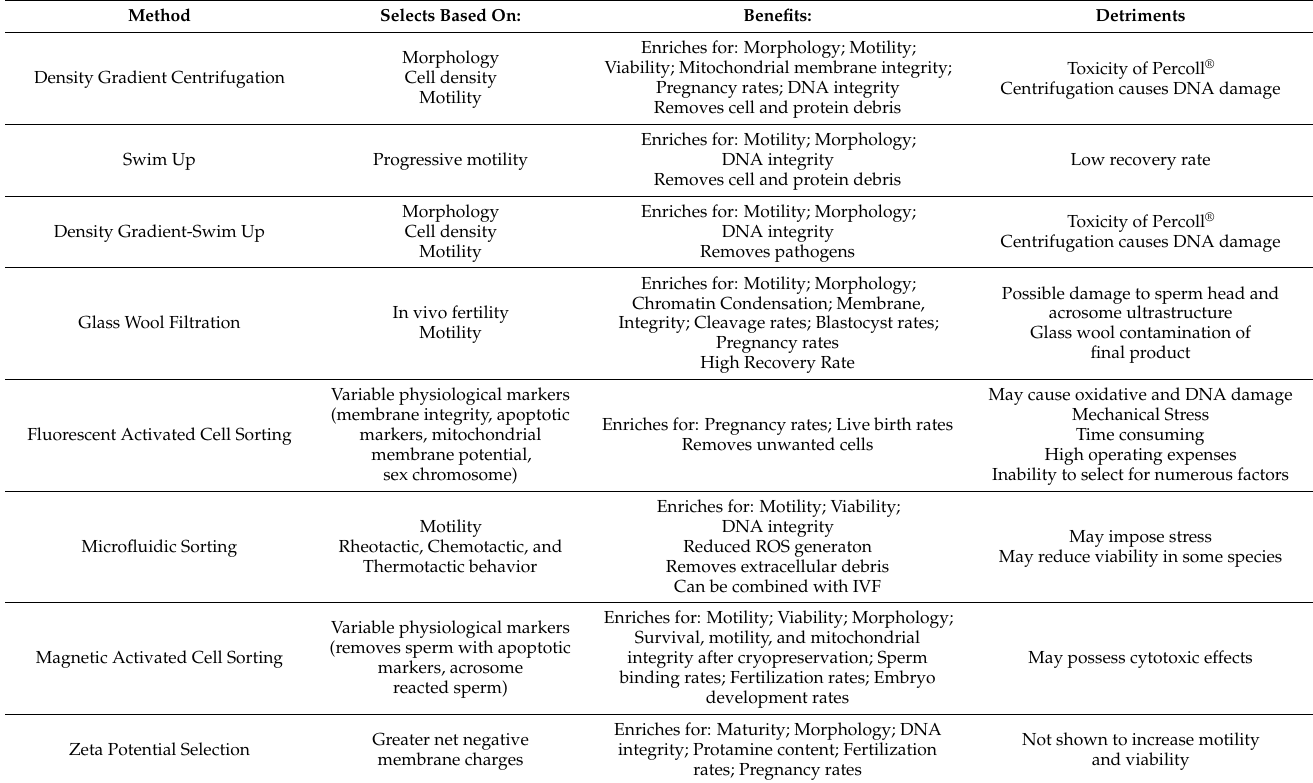
Table 1. Sperm selection techniques select for a variety of sperm parameters and are capable of reducing percentages of negative factors within a sample, although some methods may have detrimental